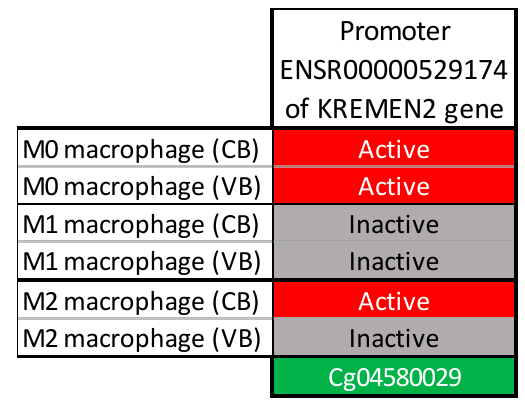
Figure 3. Regulatory status of the ENSR00000529174 promoter according to the macrophage cell type (CB: cord blood; VB: vein blood).